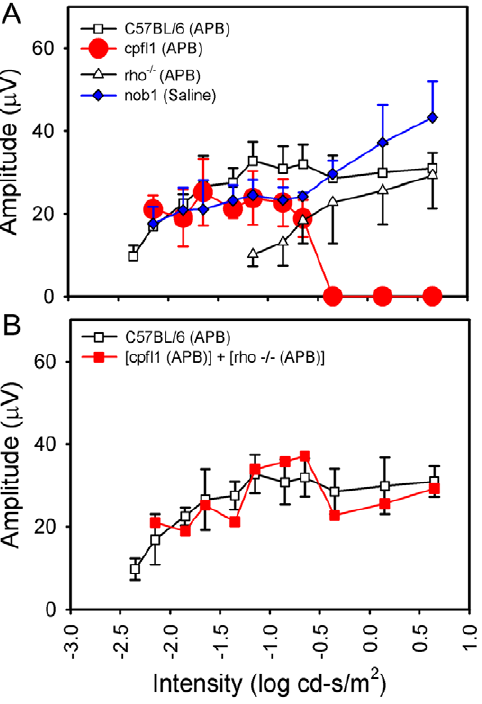
Figure 6. The amplitude-intensity curves of the rod- and cone- driven 10-Hz flicker ERG OFF pathway responses in mice. The OFF response threshold of the APB-treated C57BL/6 mice (n=5) is 2 2.35 log cd-s/m 2 (Panel A). The amplitude increases with the intensity and reaches a plateau starting at 2 1.15 log cd-s/m 2 . The response threshold of the APB-injected rho 2 / 2 mice (n=4) is 2 1.15 log cd-s/m 2 . The flicker ERG OFF pathway responses of the APB-injected cpfl1 mice (n=5) are seen at a light intensity range of 2 2.15 , 2 0.65 log cd-s/m 2 . The threshold of the saline-injected nob1 mice (n=7) is comparable to that of the APB-injected wild-type mice. The summation of the flicker ERG amplitude-intensity curves of the APB-injected rho 2 / 2 and cpfl1 mice resembles the profile of the APB-injected C57BL/6 mice. ((Panel B. Bars indicate the standard deviation.).